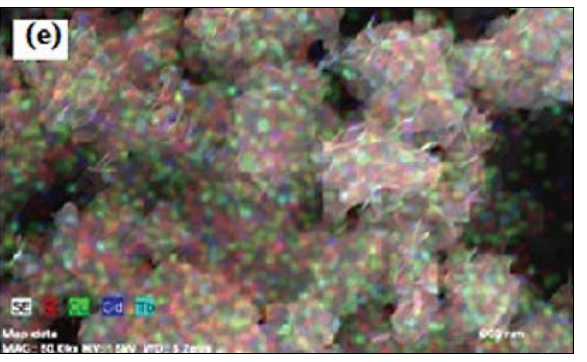
Figure 4. Elemental mapping images for (a) undoped CdS (b) CdS:Cu 2+ (c) CdS:Cu 2+ Gd 3+ (d) CdS:Cu 2+ Er 3+ (e) CdS:Cu 2+ Tb 3+